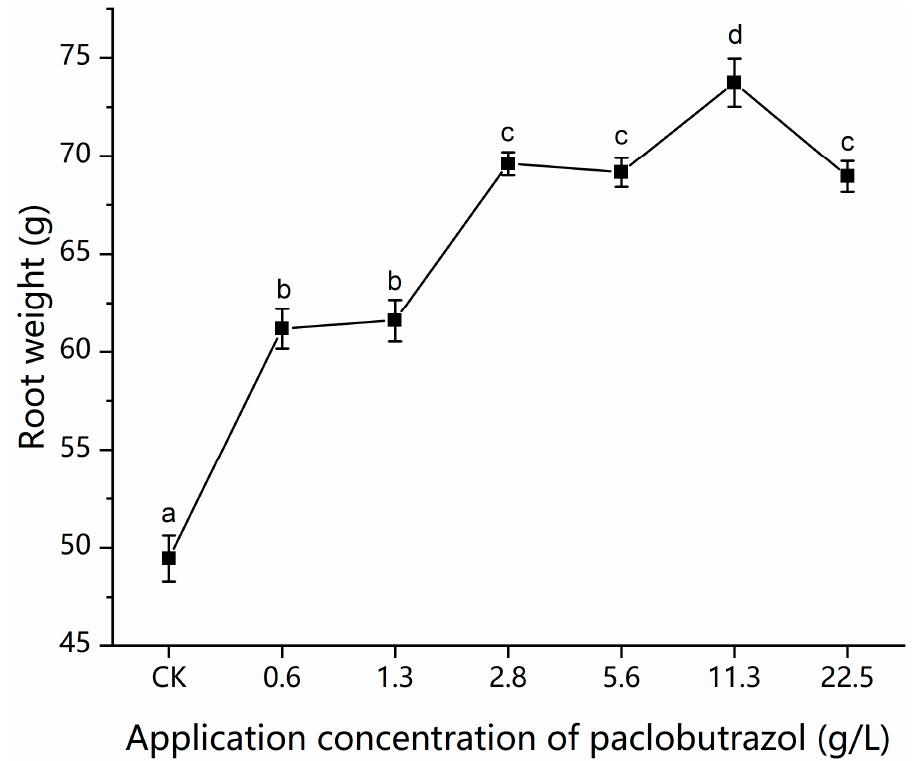
Figure 5. Effects of paclobutrazol concentration on root weight of O. japonicus. Different letters (a, b, and c) represent significant differences ( p ≤ 0.01) across treatments according to Tukey’s SD test; Vertical bars represent standard errors.